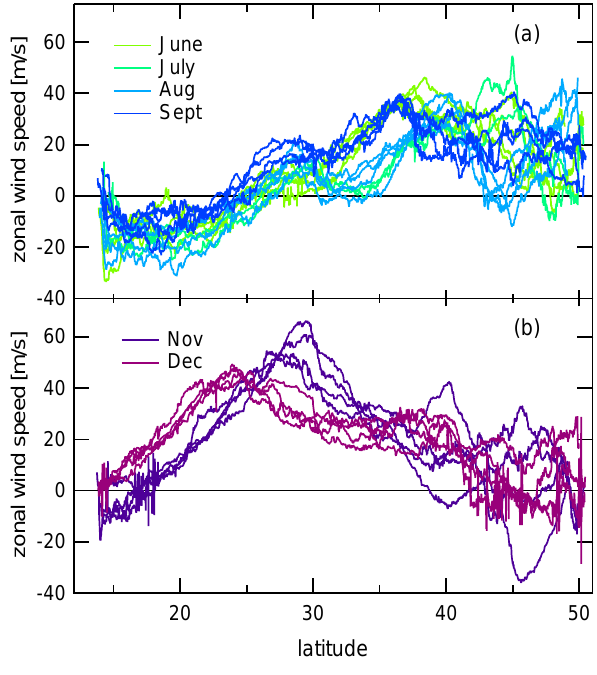
Fig. 2. Zonal wind speed as a function of latitude observed dur- ing CARIBIC flights to India in summer and winter 2008. Spring and autumn months are not shown. Positive wind speeds indicate westerly flows, negative wind speeds easterly